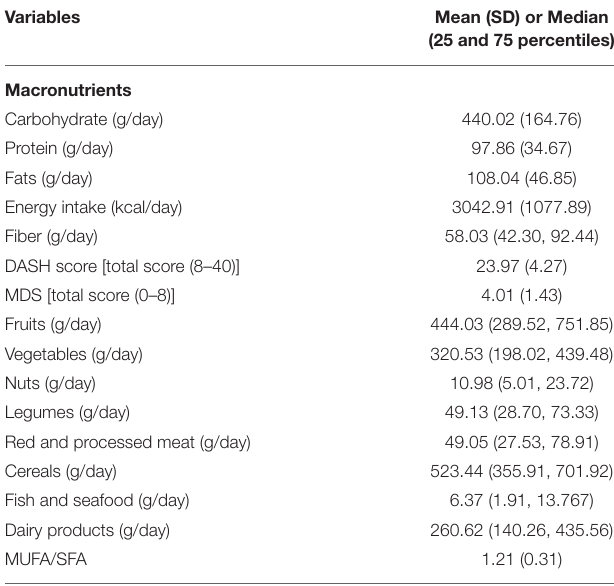
TABLE 2 | Daily dietary intake of macronutrients, energy and several food groups in relation to MDS and DASH score among study